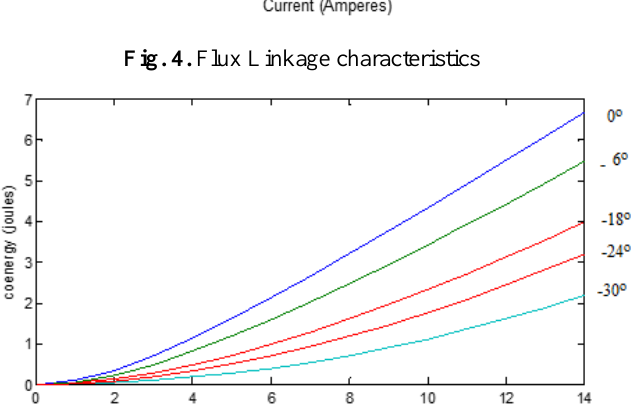
Fig. 4. Flux Linkage characteristics